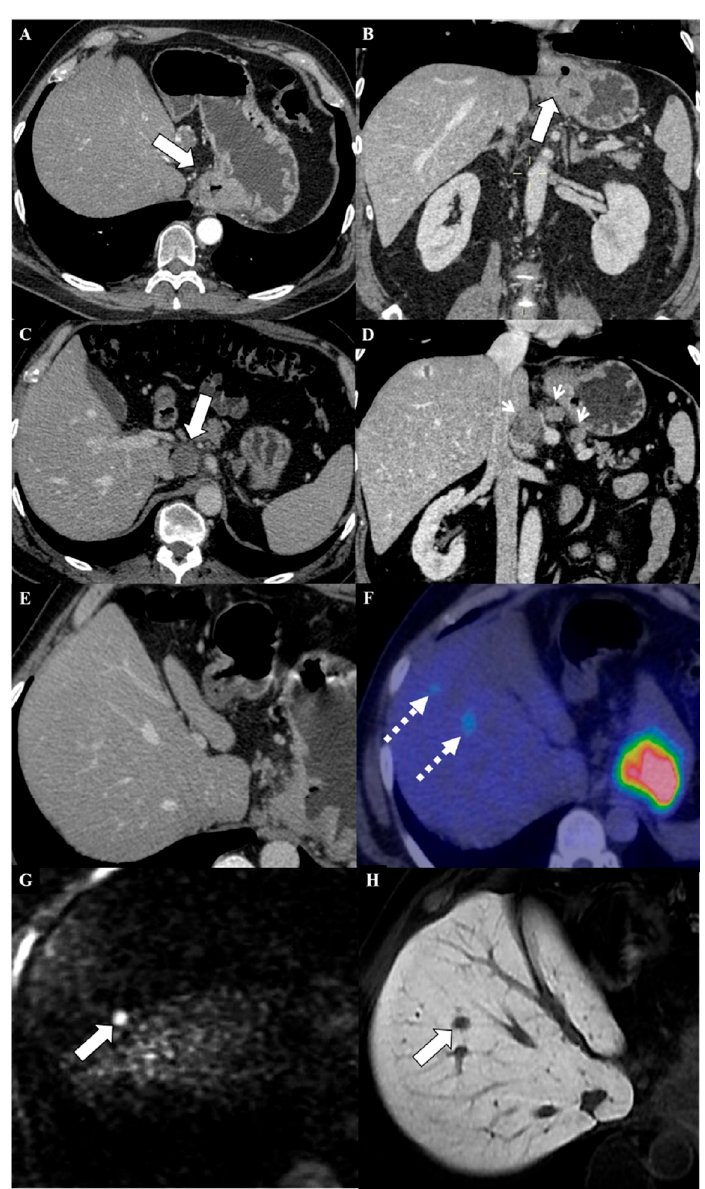
Figure 1. A 62-year-old man complaining of dysphagia and epigastric pain with advanced stage gastric cancer. Axial ( A ) and coronal reformatted ( B ) contrast-enhanced computed tomography (CT) images showed a circumferential soft-tissue thickening involving the gastroesophageal junction and the cardia of the stomach (white arrows) invading the serosa layer (T-stage: T4a). Multiple (3) enlarged lymph nodes were appreciable in the aortocaval ( C ) (white arrow) and celiac ( D ) (arrowheads) region (N-stage: N2). Axial contrast-enhanced CT scan ( E ) did not demonstrate liver metastasis, whereas the axial 18 FDG positron emission tomography computed tomography (PET-CT) image ( F ) revealed two metabolically active lesions with the same uptake value (SUVmax 4.7) located in the VIII hepatic segment (dotted arrows), consistent with M1 disease. The subsequent axial gadoxetic acid-enhanced magnetic resonance imaging, performed using diffusion-weighted imaging ( G ) and during the hepatobiliary phase ( H ), confirmed only one metastatic lesion (white arrow).